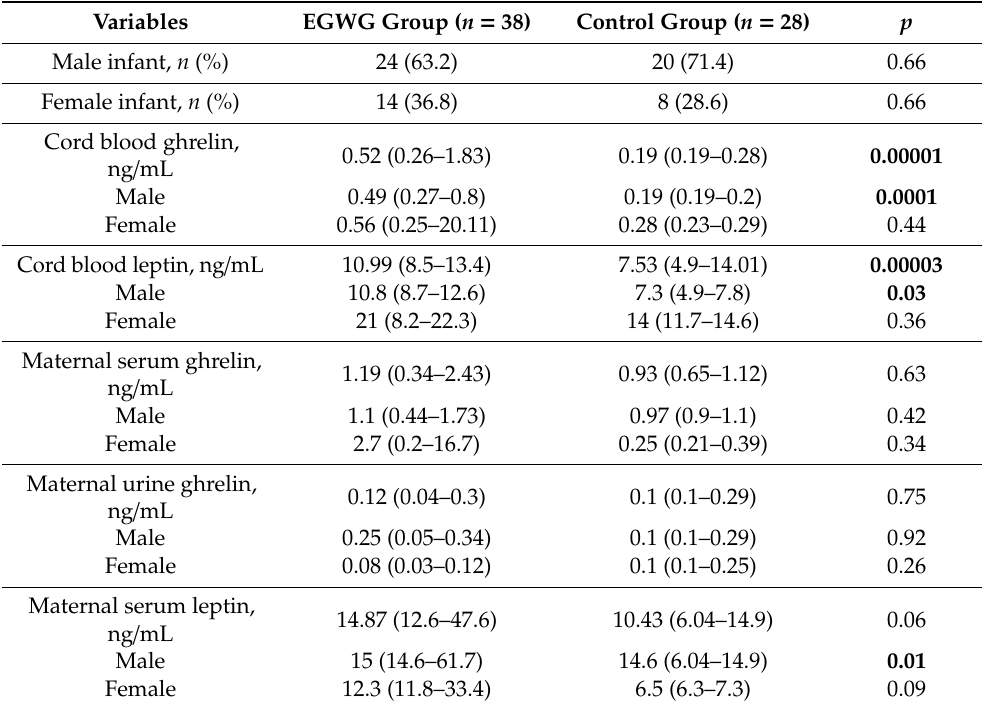
Table 1. Comparison of the study groups.